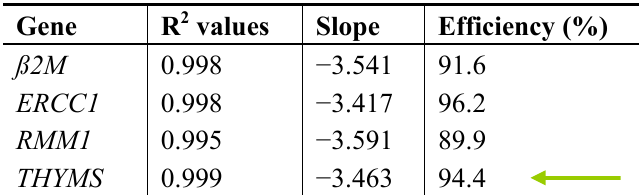
Table 5. Quality assurance: PCR